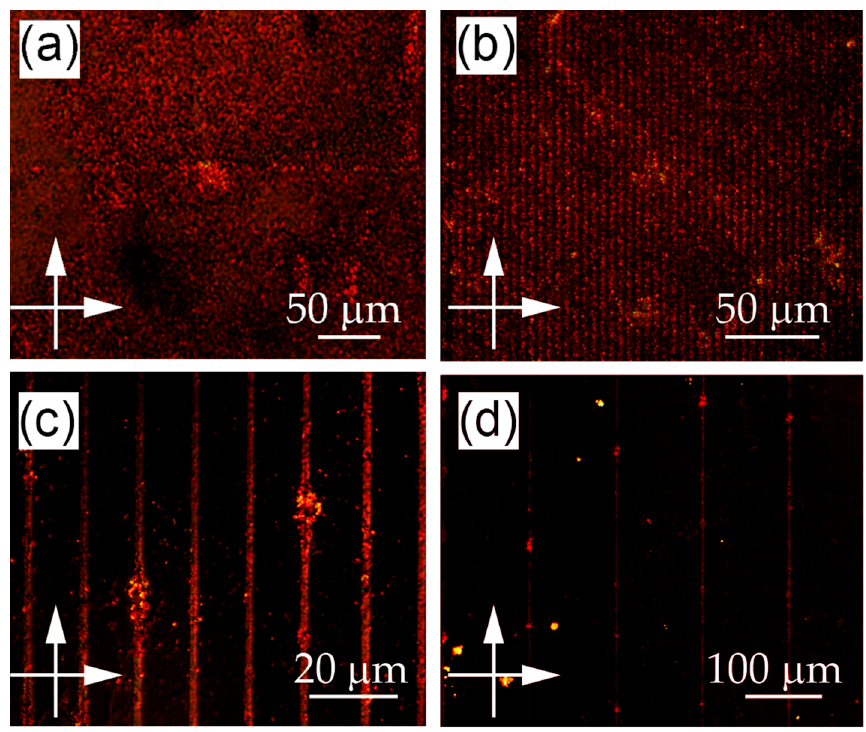
Figure 1. Microscope optical images, acquired between crossed polarizers, of the GNP gratings with period of ( a ) 0.5 µm; ( b ) 2 µm; ( c ) 10 µm; ( d ) 100 µm.